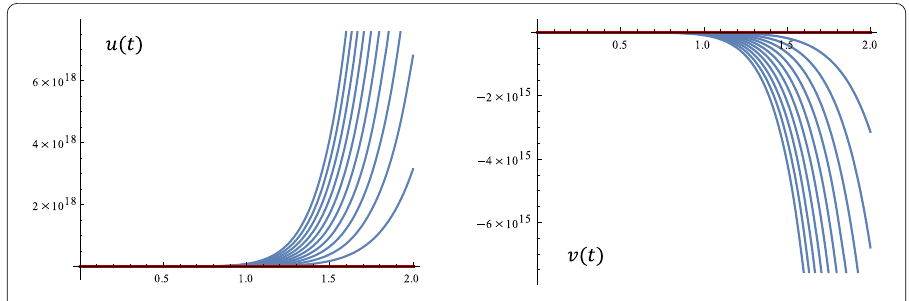
Figure 5 The solutions behavior of Example 4.2 for α i = 0.95 + 0.005 i , i = 0,1, ... ,9